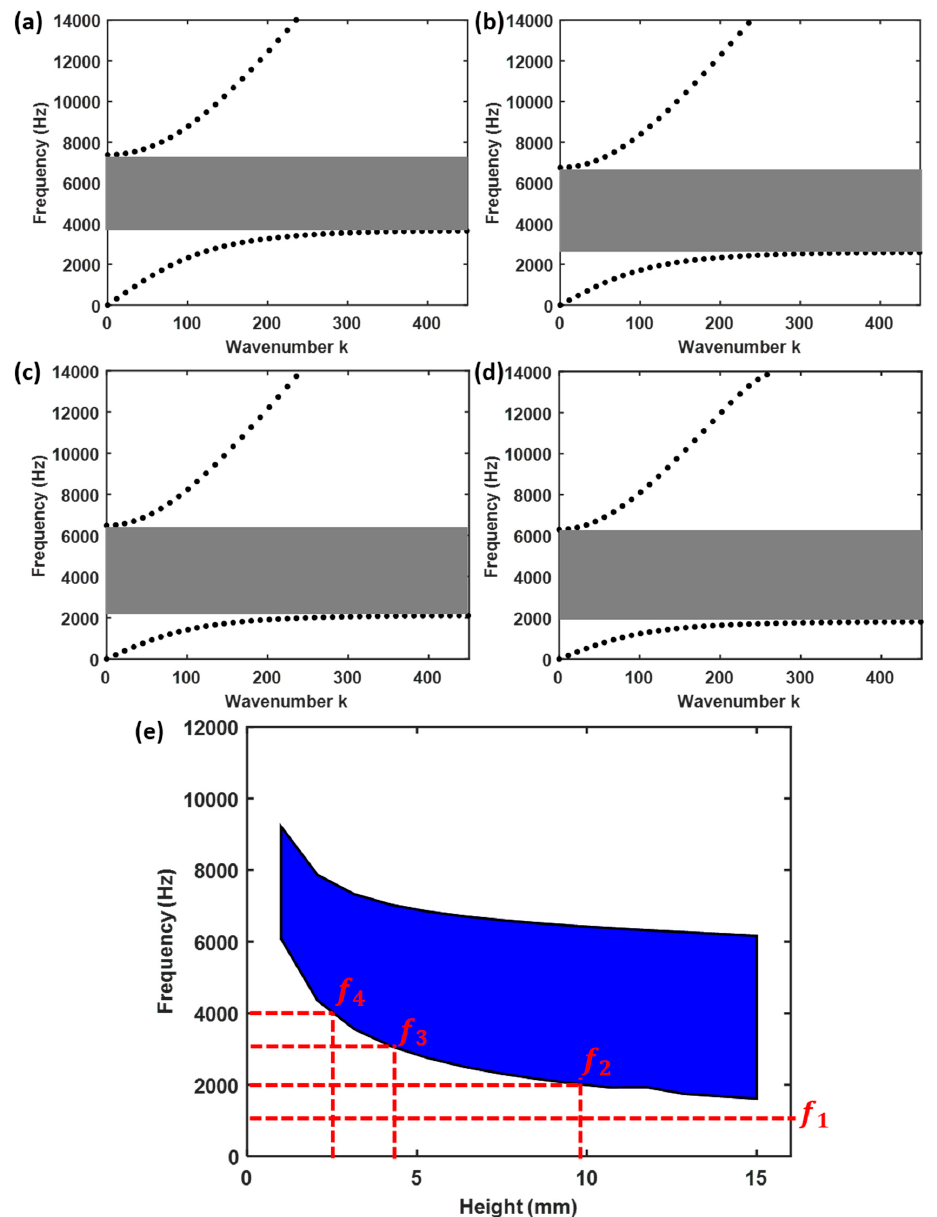
Figure 2. Dispersion curve analysis of graded Helmholtz resonators. Frequency-wavenumber dispersion curves in the first Brillouin zone for unit cell with cylinder height ( a ) h = 3 mm, ( b ) h = 6 mm, ( c ) h = 9 mm, ( d ) h = 12 mm. ( e ) Variation of bandgap with respect to cylinder height. The blue shaded area represents the bandgaps.